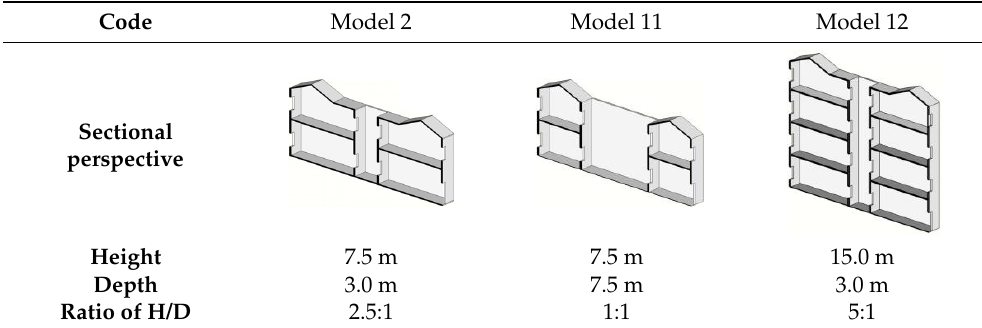
Figure 11. APMV values in Models 2–10 at 12:00 at 1.2 m height on each floor. Table 6. Different sectional shape of the courtyard.